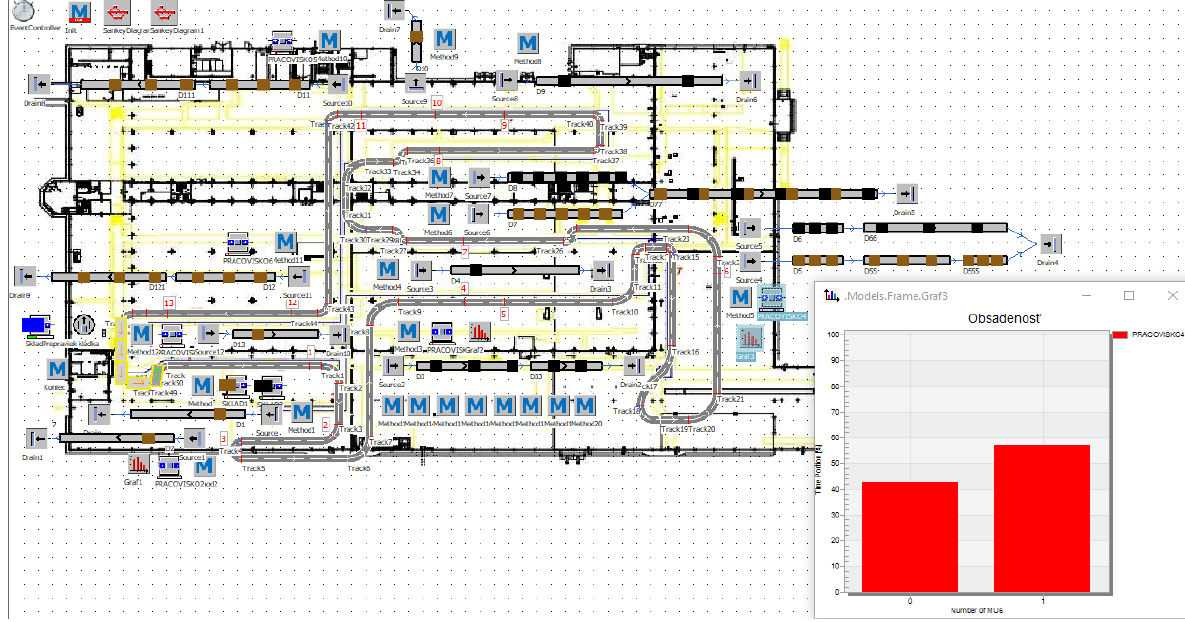
Figure 4: Demonstration of visualization of the results of workplace occupancy